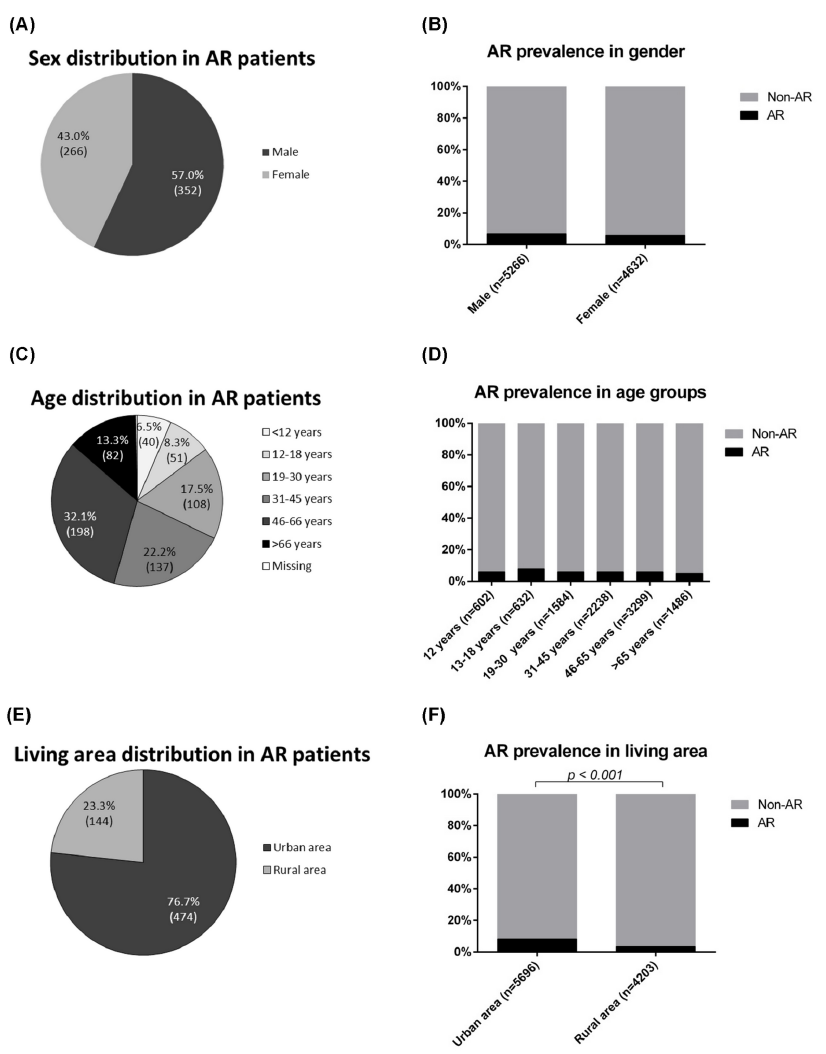
Fig. 2. Epidemiological characteristics of AR. Sex distribution (A), age distribution (C), and living area distribution (E) of AR patients. The prevalence of AR in different age groups (B), in sex (D), and in different living areas (F). Exact number was indicated in the brackets in pie charts. Chi-square test was used to analyze the difference of the prevalence rate within each demographic group. A p -value below 0.05 was considered statistically